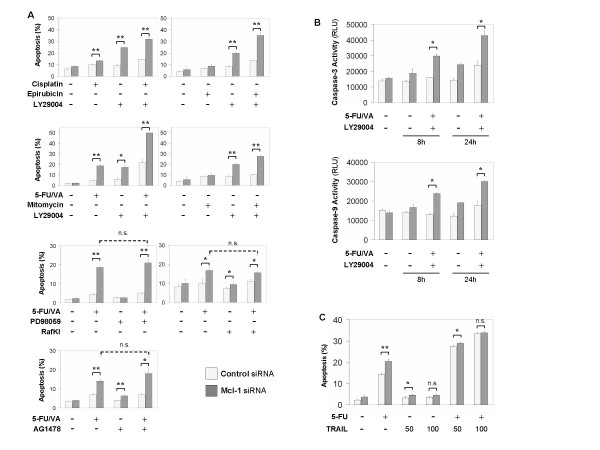
Mcl-1 interference sensitizes HCC cells towards combined treatment modalities. (A) Huh7 cells were transfected with siRNA specific for Mcl-1 (grey bars) or transfected with siRNA specific for GFP as control (light bars). After 24 h, cells were treated with chemotherapeutic drugs for another 24 h: cisplatin, 1 μg/ml, epirubicin, 200 ng/ml, 5-FU, 150 μg/ml (+ valproic acid (VA), 100 μg/ml), and mitomycin C, 5 μM. Some cultures were pre-incubated for 1 h with the kinase inhibitors LY294002 (25 μM, blocking PI3K), PD98059 (50 μM, blocking MEK1), AG1478 (5 μM, blocking EGF receptor tyrosine kinase) and a Raf I-kinase inhibitor (100 nM). Apoptosis was assessed by FACS analysis. *p < 0.05, **p < 0.001. n.s., not significant. (B) and (C) Huh7 cells were transfected with siRNA (40 nM) as described above and treated 24 h thereafter. In (B), cells were treated with 5-FU (150 μg/ml) and VA (100 μg/ml) for 8 or 24 h, as indicated. Cells were harvested and caspase-3 (upper panel) or caspase-9 activities (lower panel) were measured by applying caspase-specific fluorogenic substrates as described in the materials and methods section. *p < 0.01, **p < 0.001. (C) Cells were treated with 5-FU (150 μg/ml) for 48 h with or without simultaneous treatment with TRAIL as indicated. Apoptosis was measured using flow cytometrical analysis. Values are means + SD. *p < 0.05, **p < 0.001, n.s., not significant.